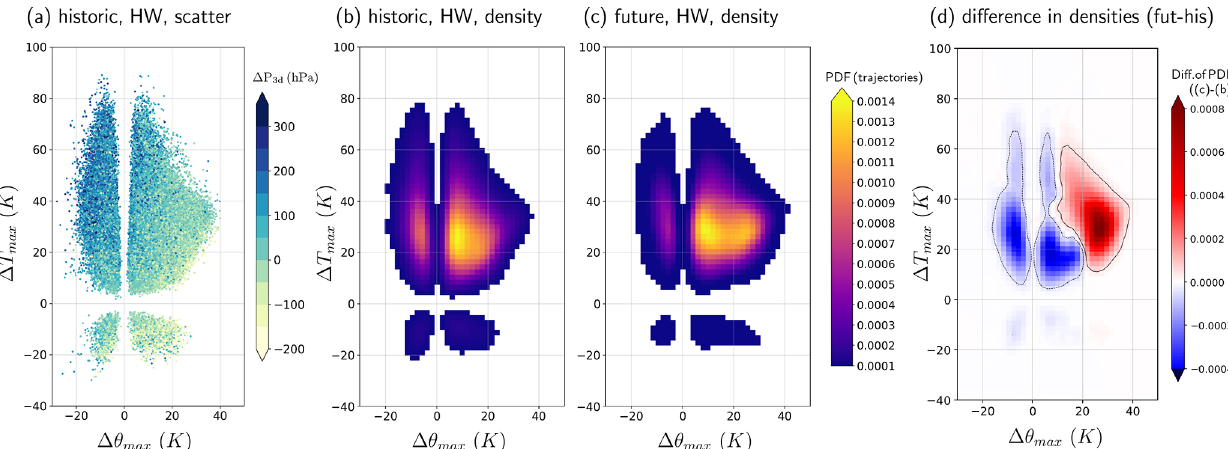
Figure 11. Maximum temperature difference (cid:49)T max along trajectories associated with heatwaves plotted against their maximum potential temperature difference (cid:49)θ max for the CE region. (a) Scatterplot with each dot representing the properties of one trajectory; descent/ascent in the 3d prior to the heatwave (cid:49)P 3d is indicated by colors; (b, c) probability density function (PDF; Gaussian kernel-density estimate) of trajectory counts (b) in the historic time slice and (c) in the future time slice. Violet to yellow colors show the probability in grid boxes of 2K × 2K. Probabilities < 0.00001 are omitted. (d) Difference between PDFs shown in panel (b) minus panel (c) ; absolute values of probability differences smaller than < 0 . 000001 are omitted. Solid (dashed) black contour marks a value of + 0 . 00005 ( − 0 . 00005) of the difference in